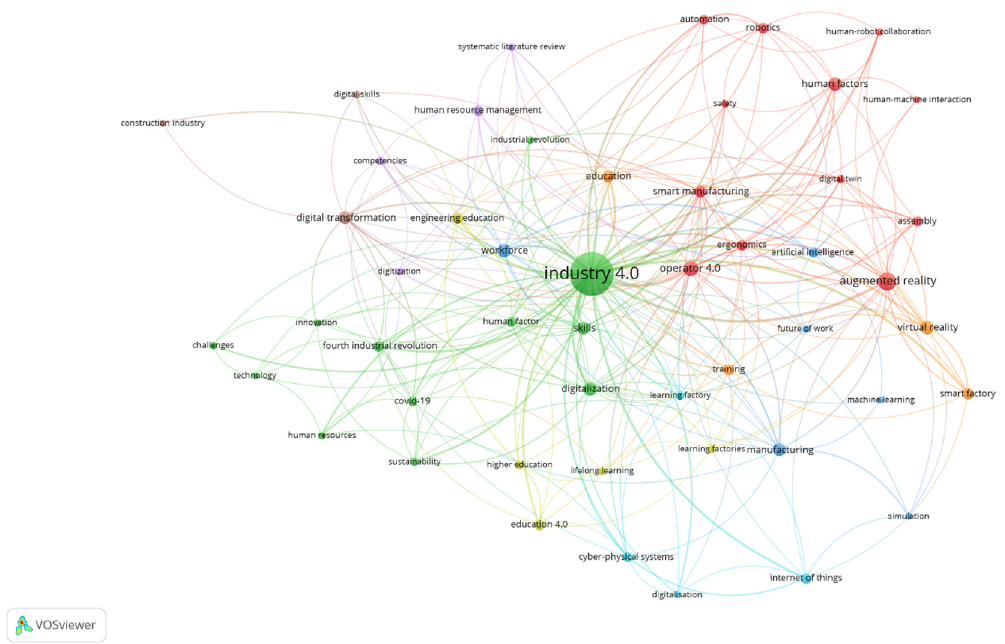
Figure 4. Database by keywords and the connectivity among them. Source: based on Scopus database edited by authors.